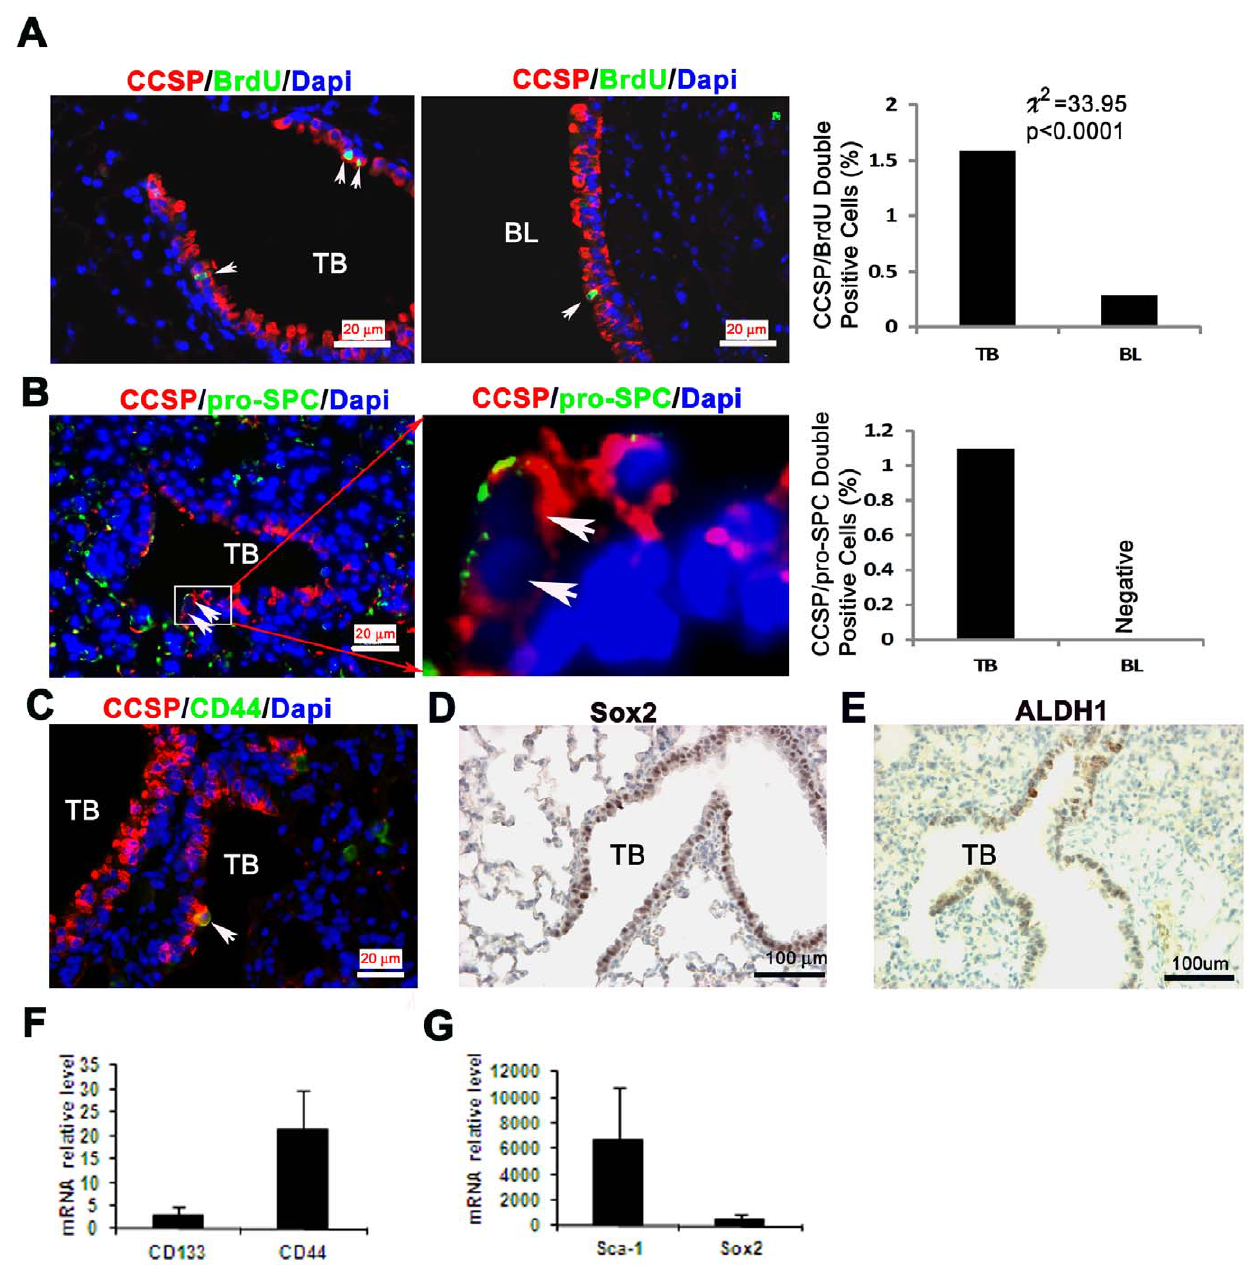
Figure 6. Evidence of stem cell features in mouse lung. A) Label retention by CCSP positive cells in airways. Double staining of BrdU and CCSP in the TB (left panel) and BL (middle panel). Barograph demonstrated the quantitative BrdU/CCSP double positive cells in TB and BL (IF, mouse number=5, total TBs=49, BLs=26). B) Bronchioalveolar stem cells (BASCs) in the airway epithelium. CCSP and pro-SPC double immunofluorescence staining. Double positive cells were represented in TB (Left and middle panel, white arrow). Barograph showed the quantitative CCSP/Pro-SPC double positive cells in TB and BL. (IF, mouse number=7, total TBs=21, BLs=20) C) A solitary double CD44/CCSP positive cell in a TB (immunofluorescence staining, bar=20 m m). D) Sox2 nuclear (immunoperoxidase staining, bar=100 m m), E) ALDH1 (immunperoxidase staining, bar=100 m m) F-G) Bar graphs of qRT-PCR analyses for the relative expression of CD133, CD44, Sca-1 and Sox2 mRNAs in mouse lungs (mean 6 SD).